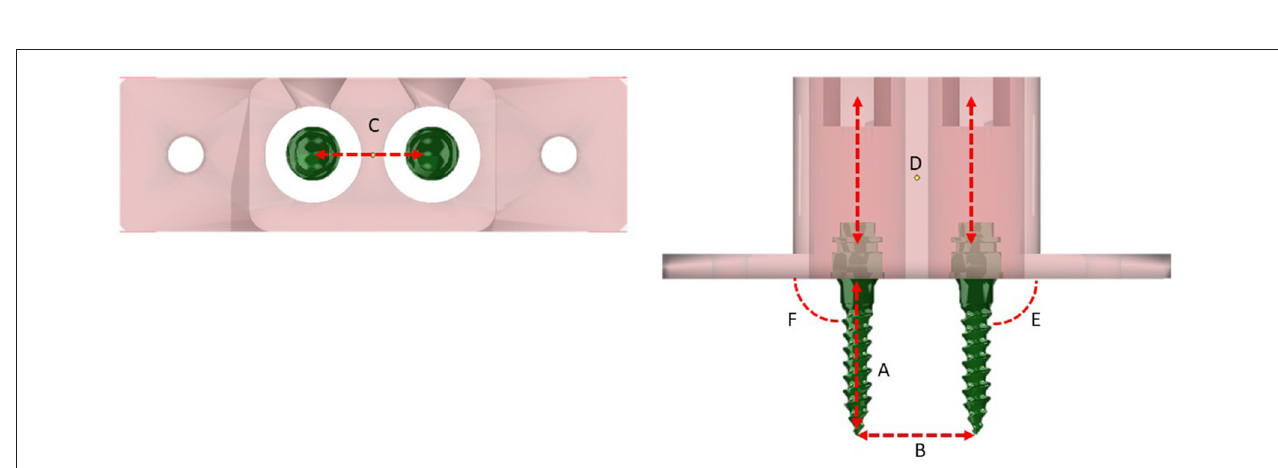
FIGURE 5 | Measurements post insertion. (A) Insertion depth of the mini-implants. (B) Apical distance between the mini-implants. (C) Coronal distance between the mini-implants. (D) An angle of the mini-implants to one another. (E,F) An angle of the mini-implants to the surface of the bone substitute material.